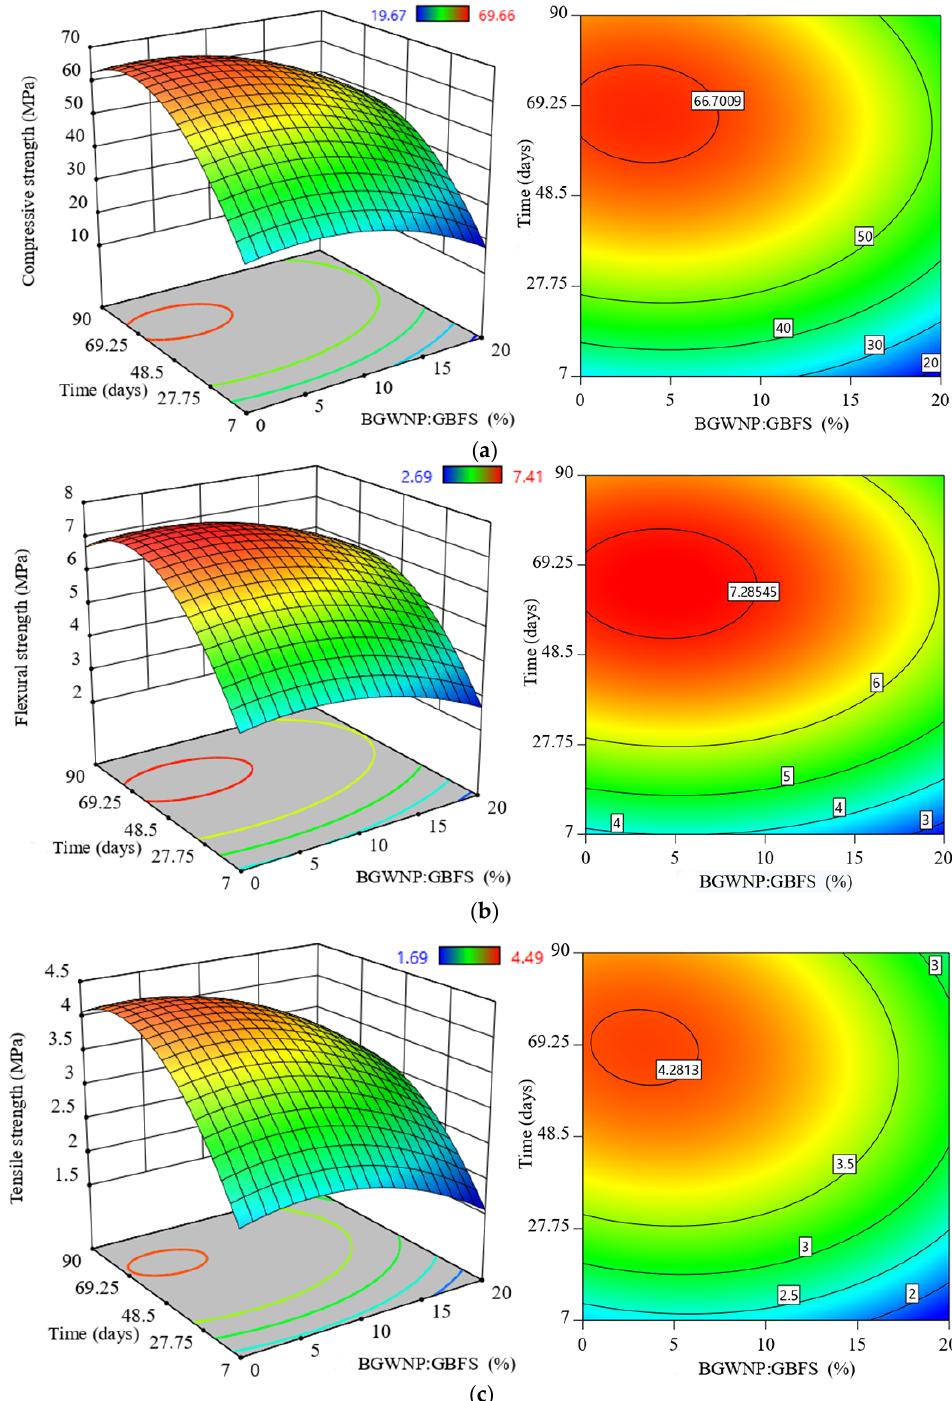
Figure 8. Evolution of ( a ) compressive strength, ( b ) flexural strength, and ( c ) tensile strength of FA-GBFS-based AAM with different replacement percentages of GBFS by BGWNP.